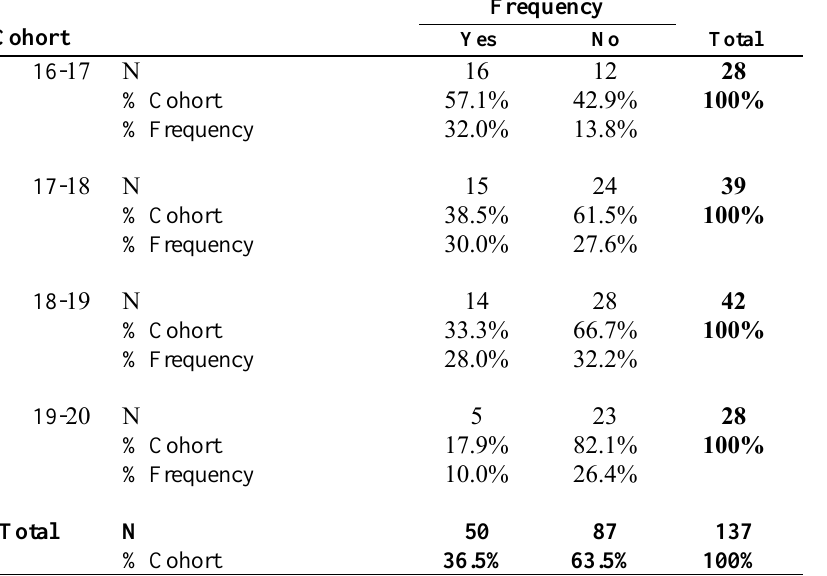
Table 3: Association between Cohorts and Frequency of Completion Student Enhancement Items